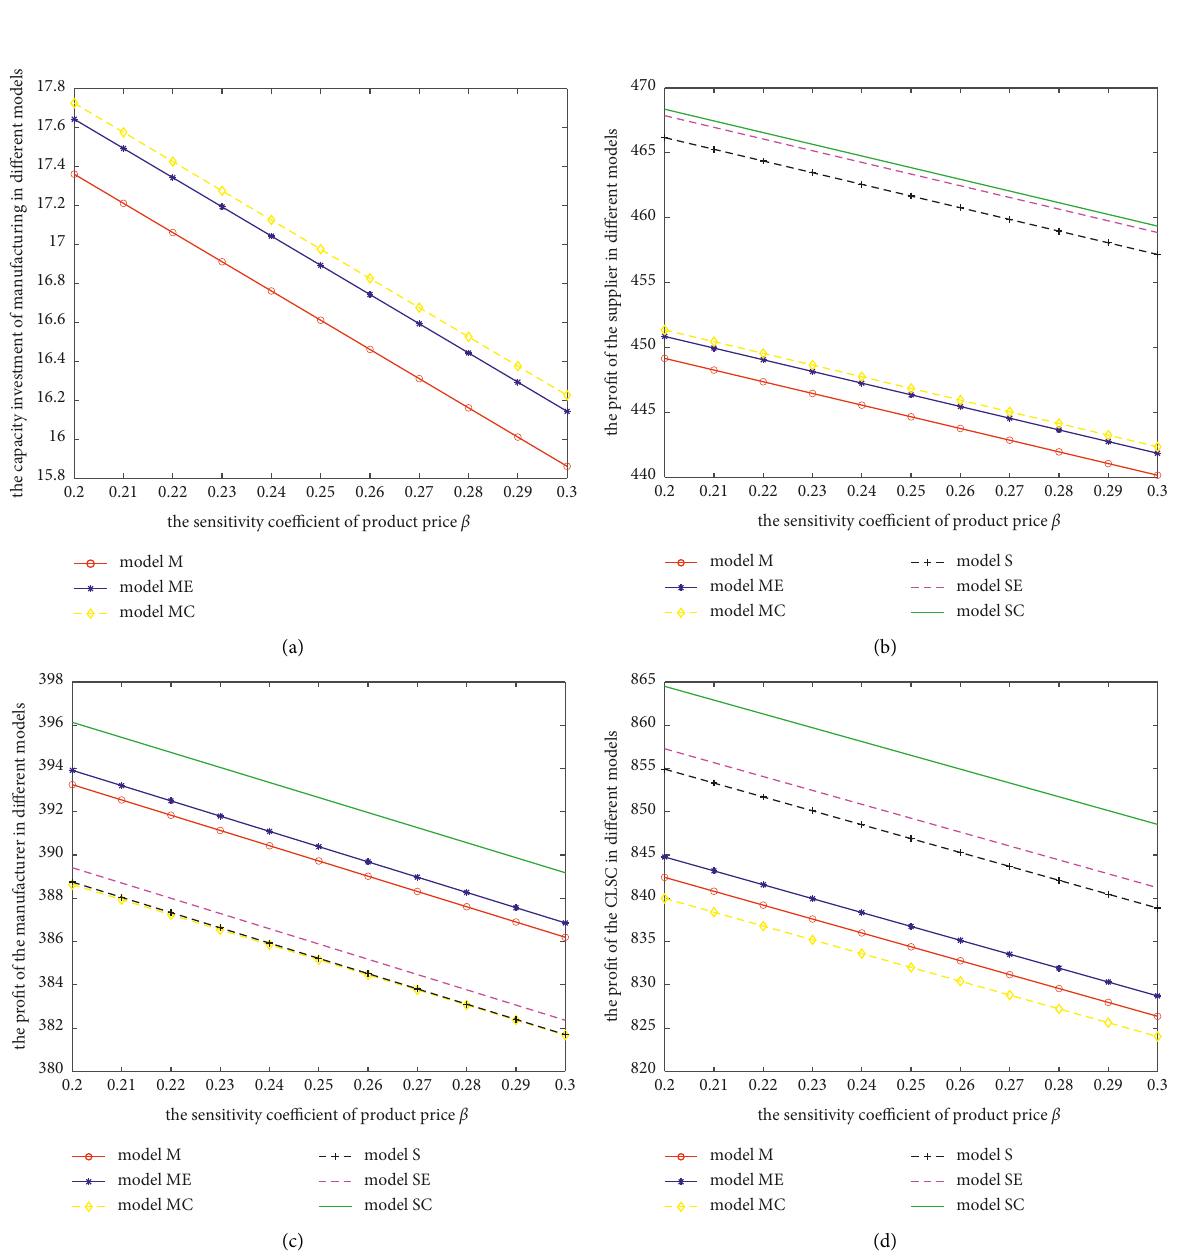
Figure 2: The sensitivity coefficient of product price β . (a) The capacity investment manufacturing in different models. (b) The profit of the supplier in different models. (c) The profit of the manufacturer in different models. (d) The profit of the CLSC in different models.